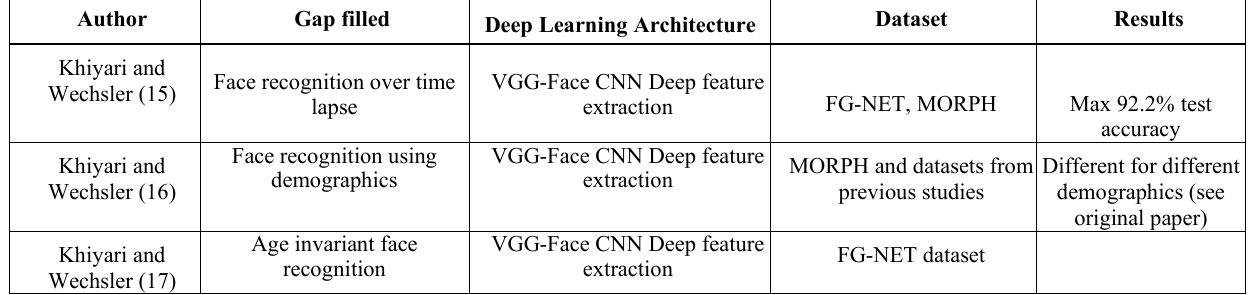
Table 1. Important works on face-based identification using deep